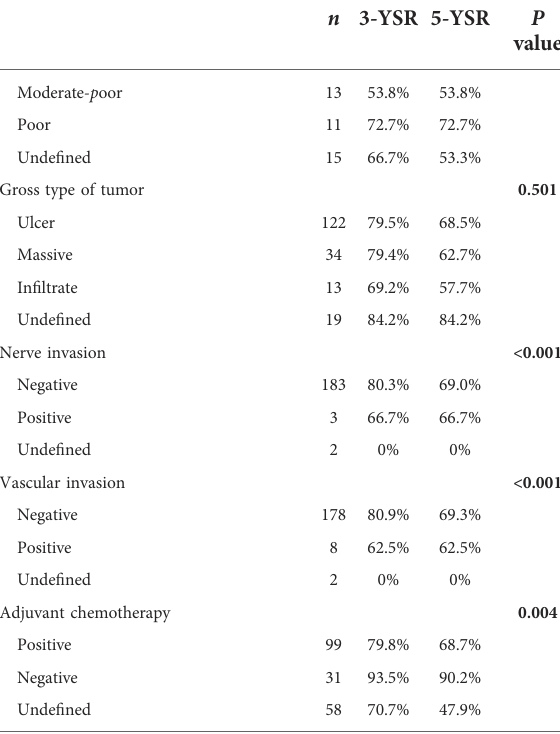
TABLE 2 Univariate analysis of the prognostic factors for patients with colon cancer. Univariate